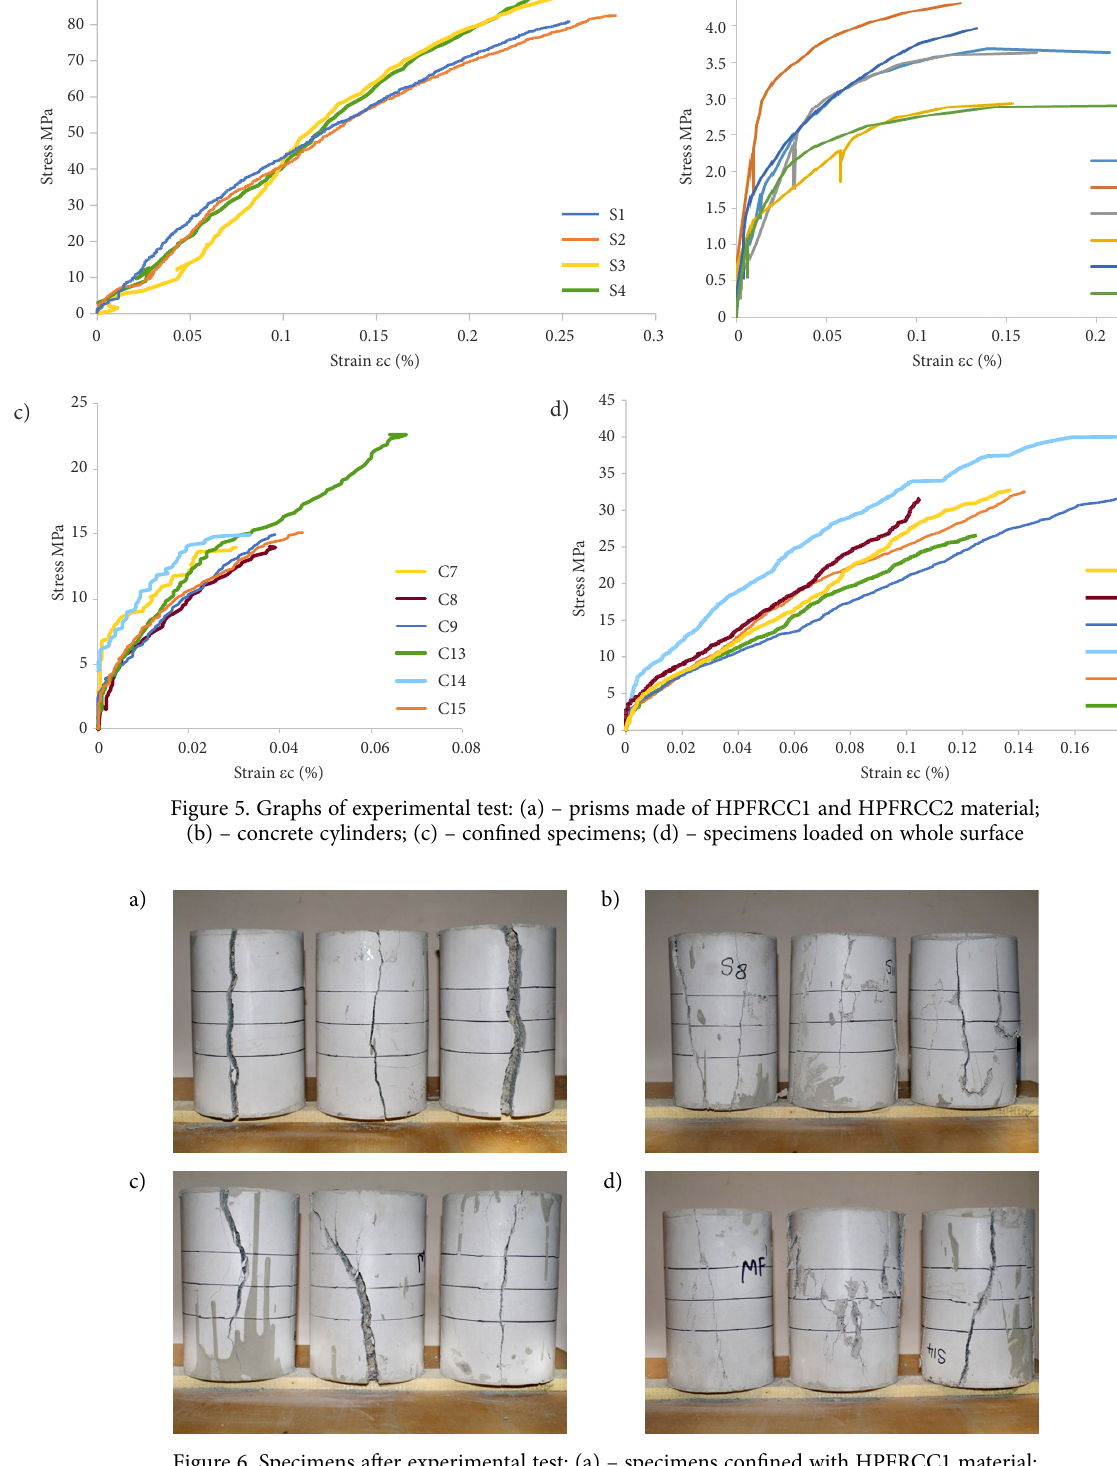
Figure 6. Specimens after experimental test: (a) – specimens confined with HPFRCC1